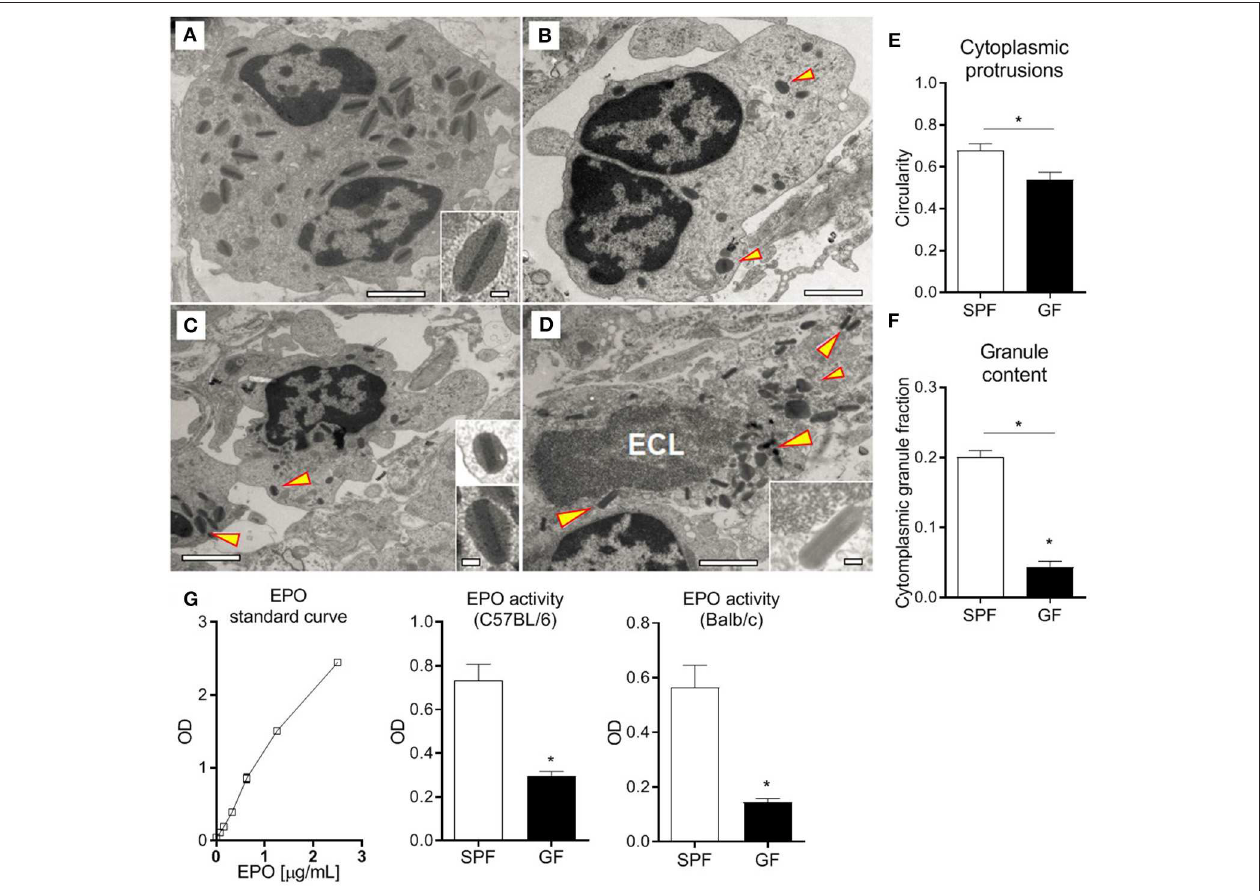
FIGURE 5 | Normal SI eosinophils transmission electron microscopy ultrastructure (A) , showing bi-lobed nuclei and a high density of granules composed of an electron-dense core surrounded by an electron-lucent matrix rich in EPO (arrowhead). SI eosinophils from GF mice (B–D) exhibit cytoplasmic protrusions, measured as reduced circularity (E) , lower content of cytoplasmic granules (F) and, occasionally, ECL signs (D) . Assessment of EPO in intestinal homogenates of SPF and GF mice (G) . Representative (A–D) and pooled (E,F) data from 6 mice, and pooled data from 2 independent experiments ( n = 6) (G) represented as mean ± SEM, * P <